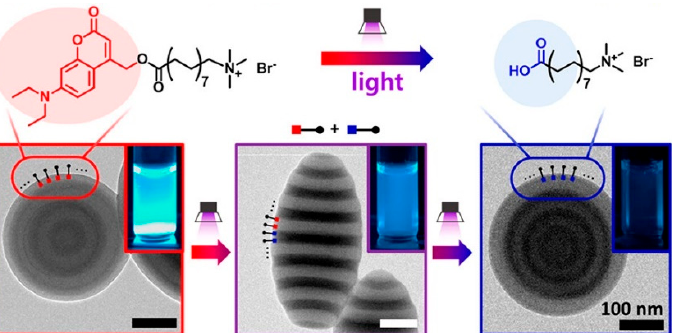
Figure 6. Light-responsive shape and color transformation of PS- b -P2VP particles prepared with surfactants having coumarin ester photo-cleavable groups (reprinted with permission from [85], Copyright 2019, American Chemical Society).